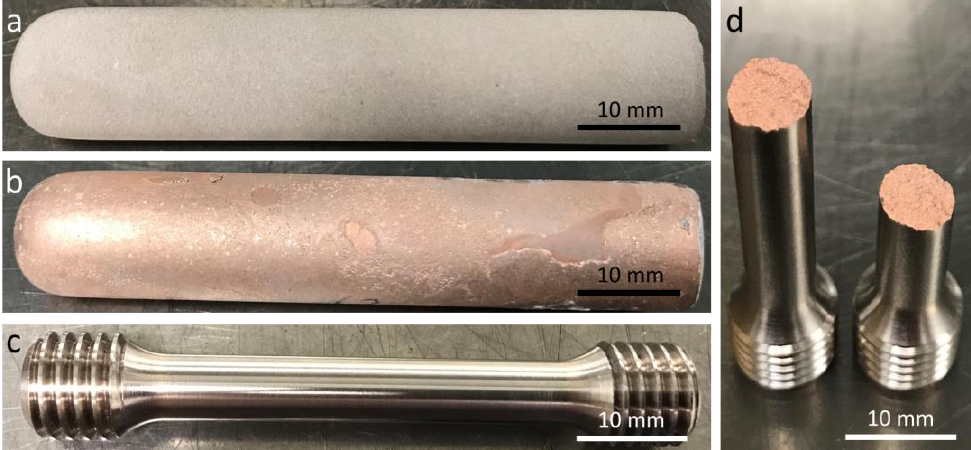
Figure 3 . Stages in preparation and testing of the H11/Cu tensile testing specimens with ( a ) porous H11 preform, ( b ) copper infiltrated blank, ( c ) machined H11/Cu tensile specimen and ( d ) tensile specimens subsequent to tensile testing.